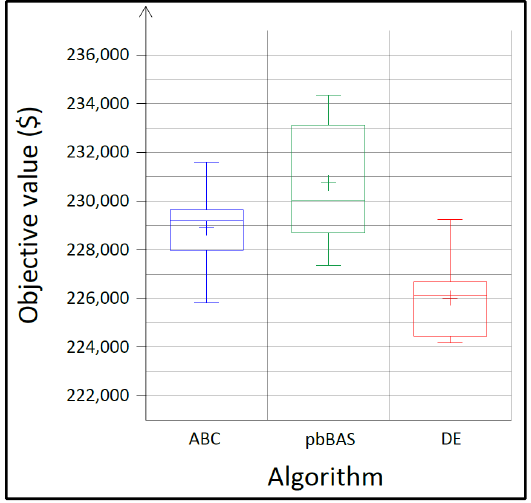
Figure 14. Design history of the worst run achieved by each metaheuristic algorithm for the V-type folded plate roof problem.